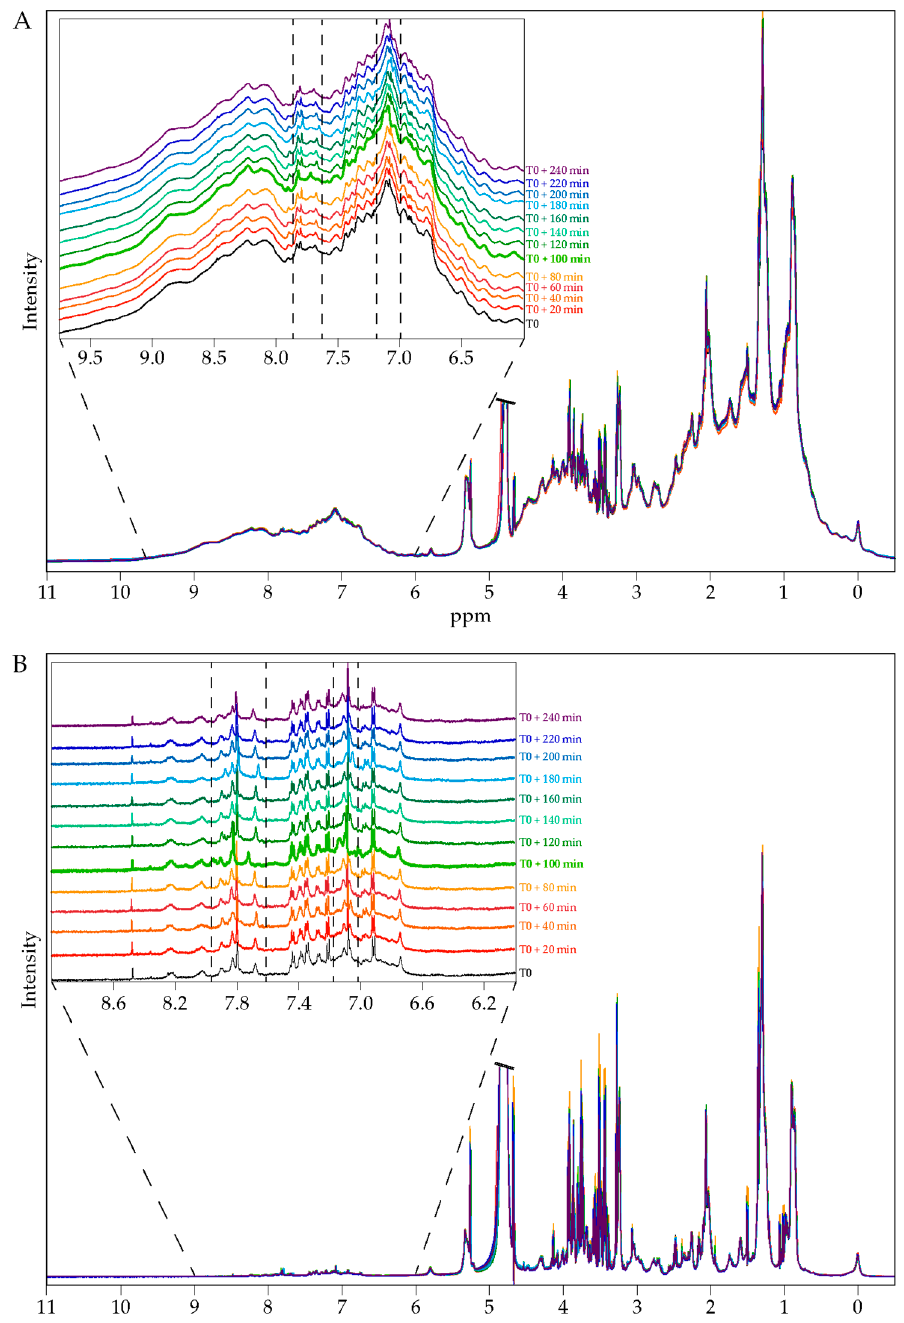
Figure 2. Overlay of 1 H NMR spectra of serum of one volunteer before and after artichoke leaf extract consumption; 1D 1 H NOESY ( A ) and 1D 1 H CMPG ( B ). Inserts in each panel show an enlargement of the phenolic region.